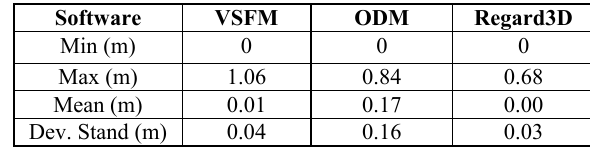
Table 3: Statistical values of the comparisons between the TLS data and the VisualSfM, ODM and Regard 3D point clouds